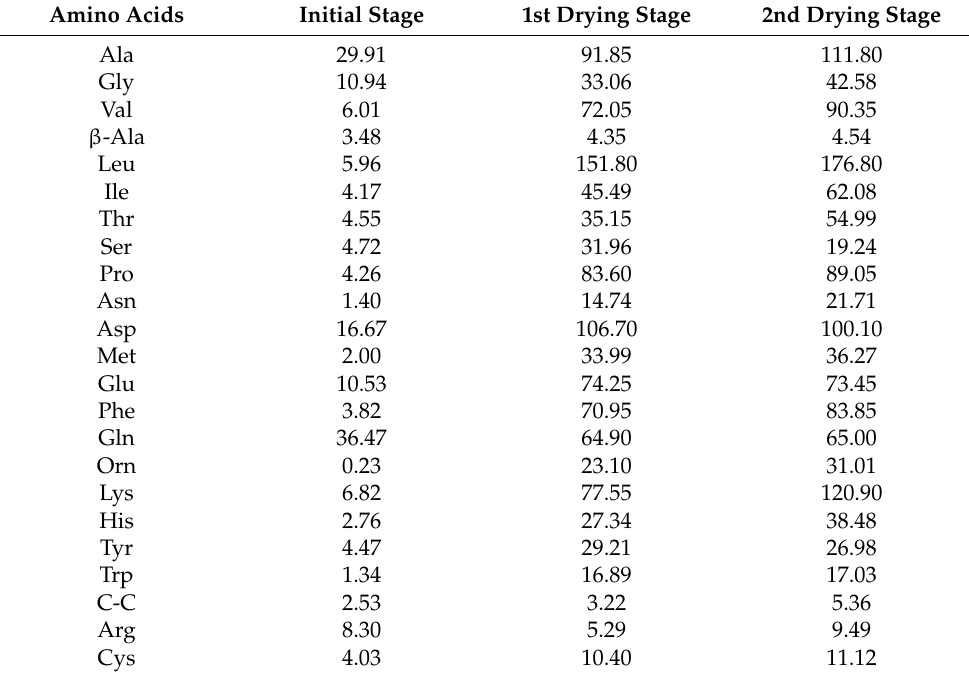
Table 2. Composition in amino acids (mg/100 mL) of each model system according to the concentra-